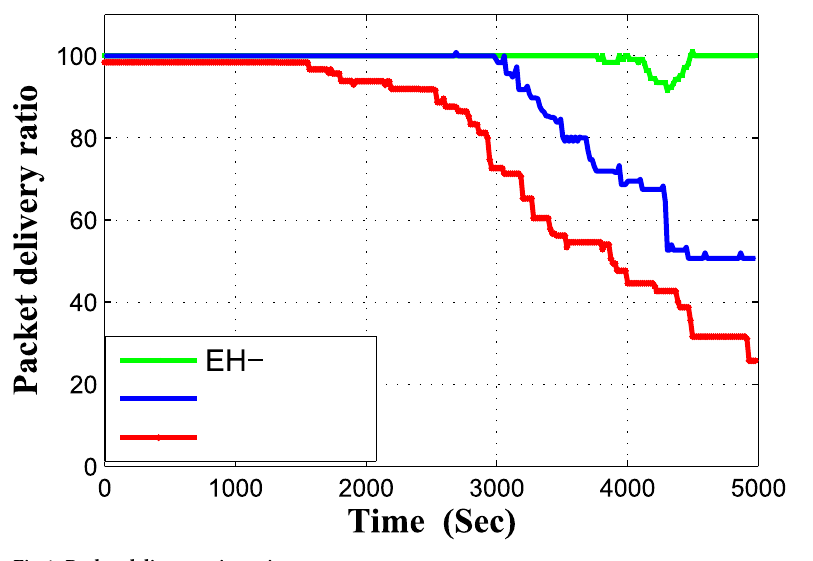
Fig 4. Packet delivery ratio vs time.